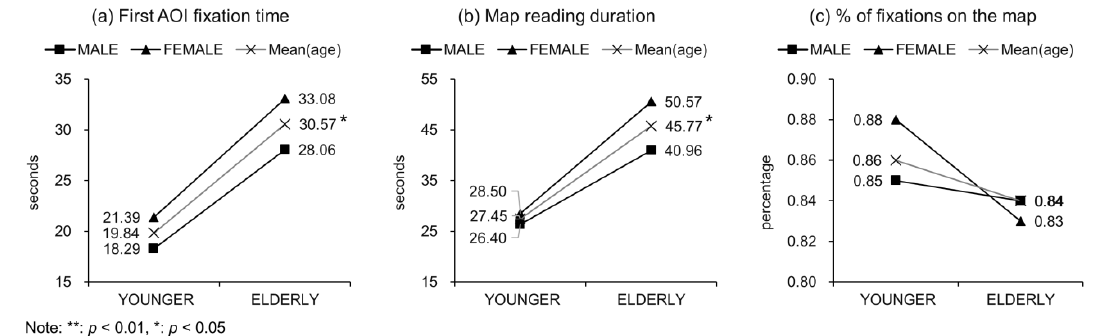
Figure 4. Results of visual attention on map reading in Task 1. Table 2. Descriptive and inferential statistics for Task 1 (Self-location).